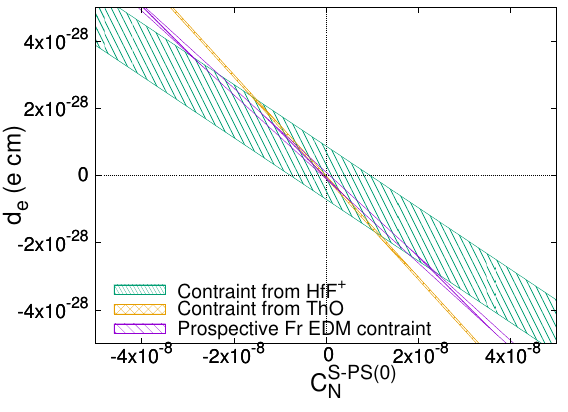
− PS(0) with the prospective sensitivity of the N